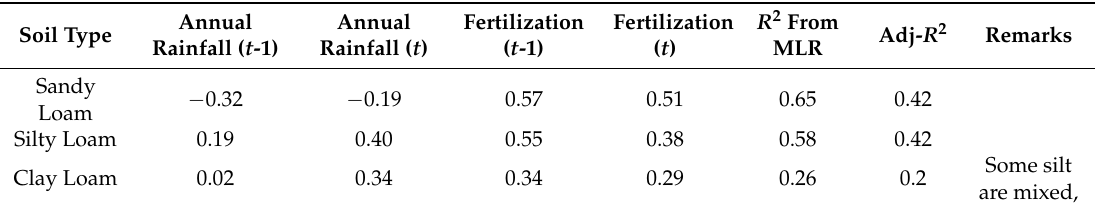
Table 1. Cross correlation of fertilization and annual rainfall of former year with nitrate leaching of current year for continuous